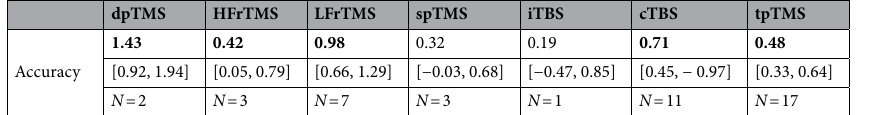
Table 2. Cohen’s d calculated using the stimulation paradigm as moderator. The effect for the study employing both TBS and HFrTMS (with aggregated effects) are not